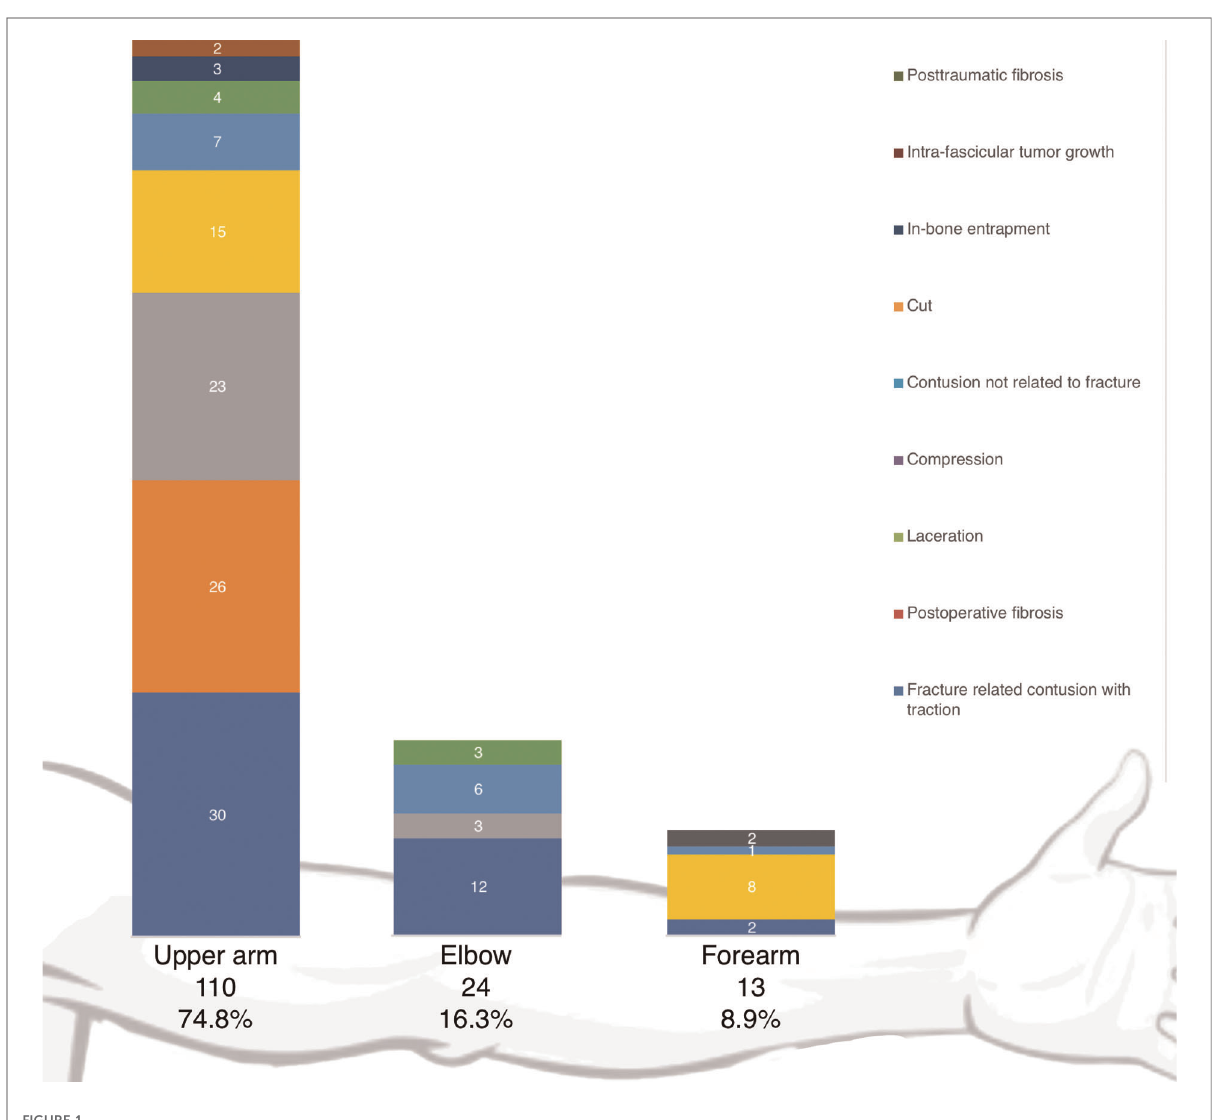
FIGURE 1 Distribution of the patients with reference to location and mechanism of nerve injury.